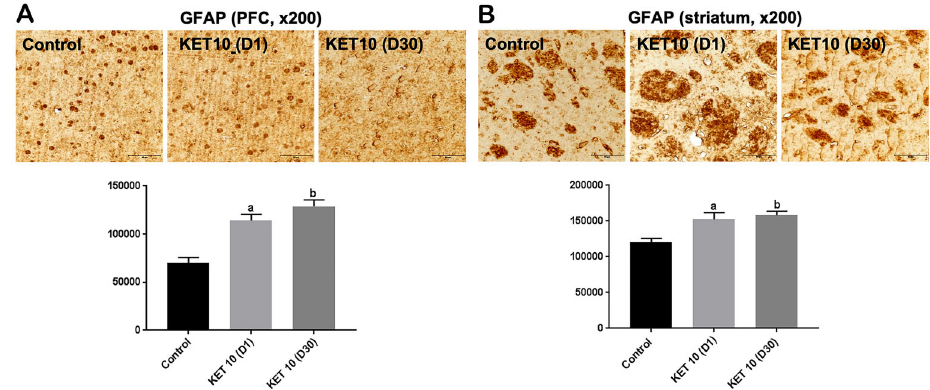
Figure 6. Single administrations of ketamine (KET, 10 mg/kg, ip ) signi fi cantly increased brain glial fi brillary acidic protein (GFAP) expression in the A ) prefrontal cortex (PFC) and B) striatum compared with controls (3 animals per group). Representative photomicrographs at (cid:1) 200 magni fi cation (50 m m), taken at D1 and D30 protocols. The graphs show the relative absorbance determined by the ImageJ software (NIH, USA). Data are reported as means ± SE. a,b P o 0.05 vs Control (one-way ANOVA and Tukey as the post hoc